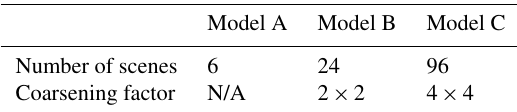
Table 1. Data used to train each of the models for Sect. 4.1. Each model is trained on a distinct aspect ratio to evaluate its influence